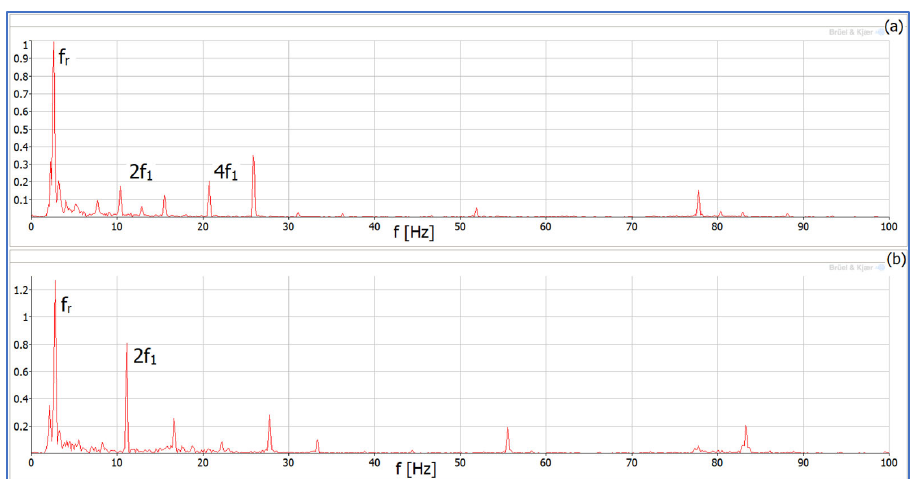
Figure 15. Vibration spectral characteristics for a rotational speed of 150 rpm and no load, where: ( a ) characteristics—1 h supply, ( b ) characteristics—1 h and 3 h supply.